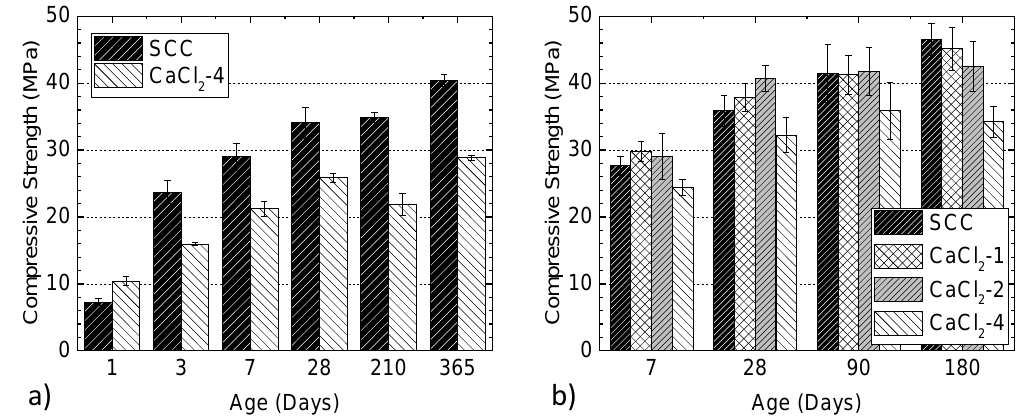
Figure 17. Effect of alkali addition on the elastic modulus of concrete at different ages. Figure 17. E ff ect of alkali addition on the elastic modulus of concrete at di ff erent ages.